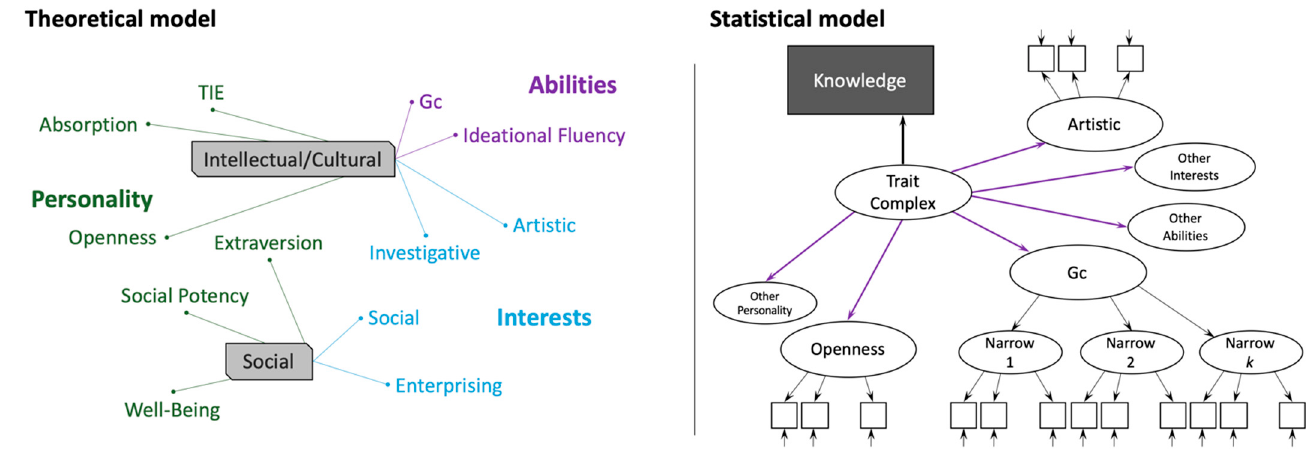
Figure 1. Schematic representation of the Intellectual/Cultural and Social trait-complexes proposed by Ackerman and Heggestad (1997). Left panel describes theoretical account; Right panel represents a reflective model of the intellectual/cultural trait-complex.